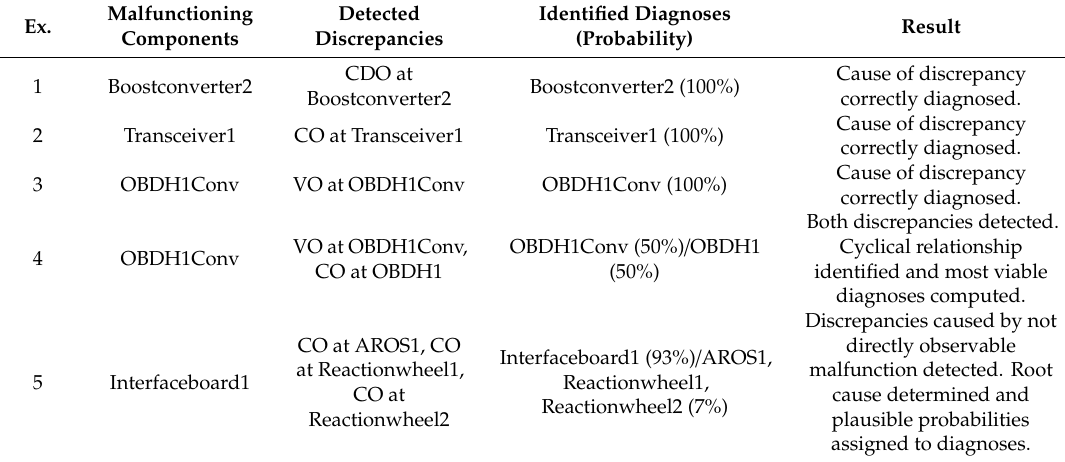
Table 2. Summary of the di ff erent experiments performed and their results